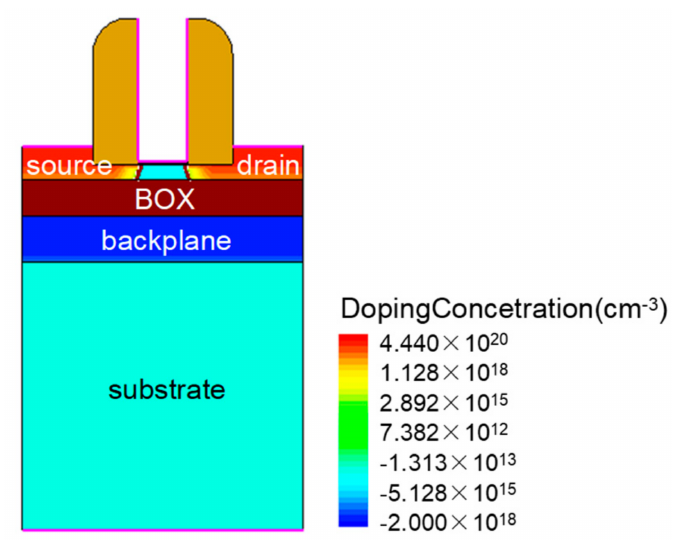
Figure 1. FDSOI device